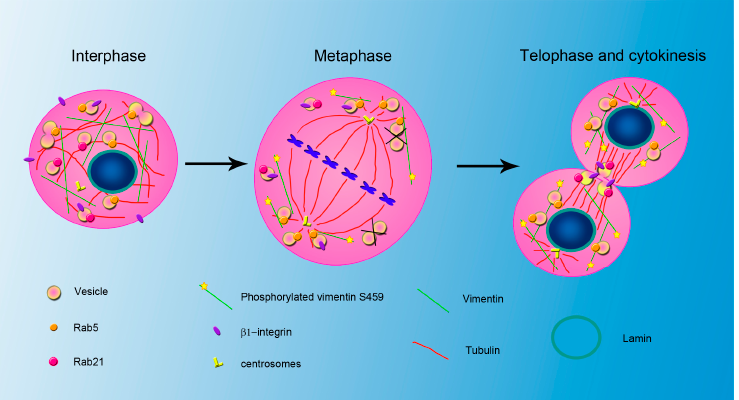
Figure 2. IFs and vesicle trafficking during cell cycle. Model representing the suggested role of Rab5, Rab21, vimentin filaments and lamins during interphase and mitosis. In interphase, Rab5-positive vesicles can localize also around the nucleus and fusion between these organelles occurs. In metaphase, nuclear lamina disassembly is controlled also by Rab5 and Rab5-positive organelles localize around the spindle poles. At this stage, vimentin filaments are phosphorylated on Ser459 and regulate Rab21 but not Rab5 association with β 1-integrin-containing vesicles. Thus, vimentin is associated with endosomes, whose fusion is blocked in metaphase. At later stages lamins are dephosphorylated, the nuclear lamina is assembled and vimentin phosphorylation on Ser459 is required for Rab21-positive β 1-integrin vesicles localization at the cleavage furrow where they fuse contributing to separation of daughter cells. Rab5-positive vesicles accumulate around the newly reformed nuclear